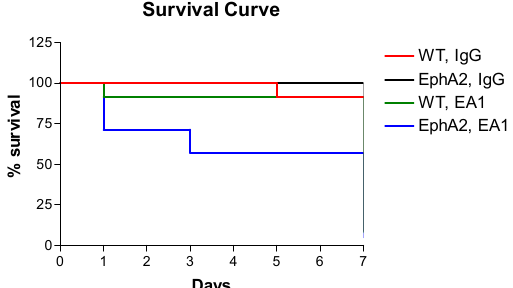
Figure 1. Kaplan–Meier Estimate Analysis Demonstrating Survival Rates in WT and EphA2-R-M Mouse Hearts. Kaplan–Meier graph showing survival rates of IgG-Fc (IgG; n = 8)- and ephrinA1-Fc (EA1; n = 11)-treated WT B6 and EphA2-R-M mice 1 week (same as 4 weeks) post-MI. These data show the poorer survival of EphA2-R mice treated with EA1 ( n = 4) compared to IgG ( n = 10) and both WT groups.